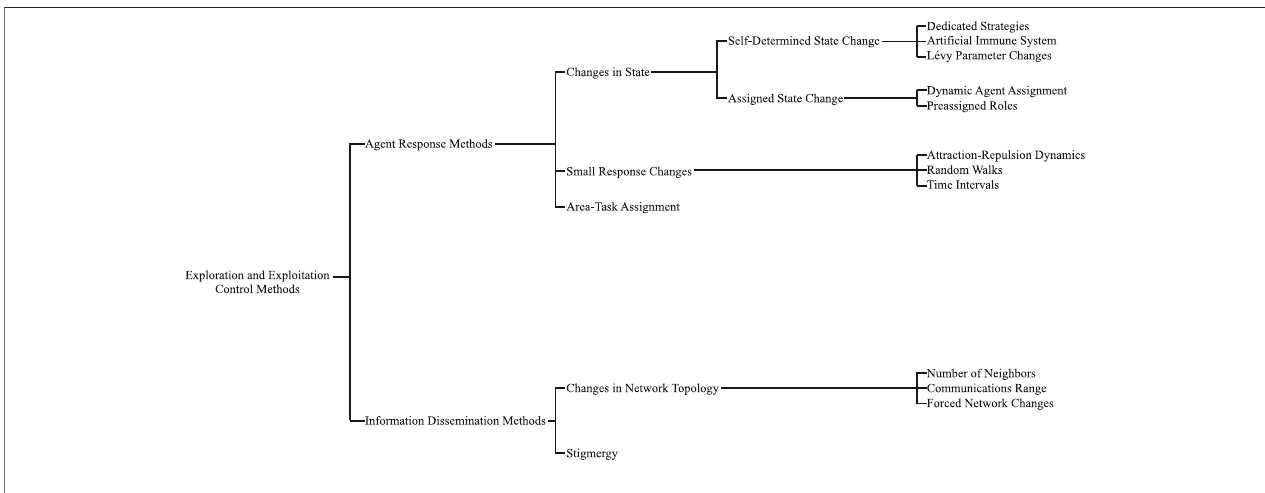
FIGURE 1 | Classi fi cation of MAS exploration and exploitation control